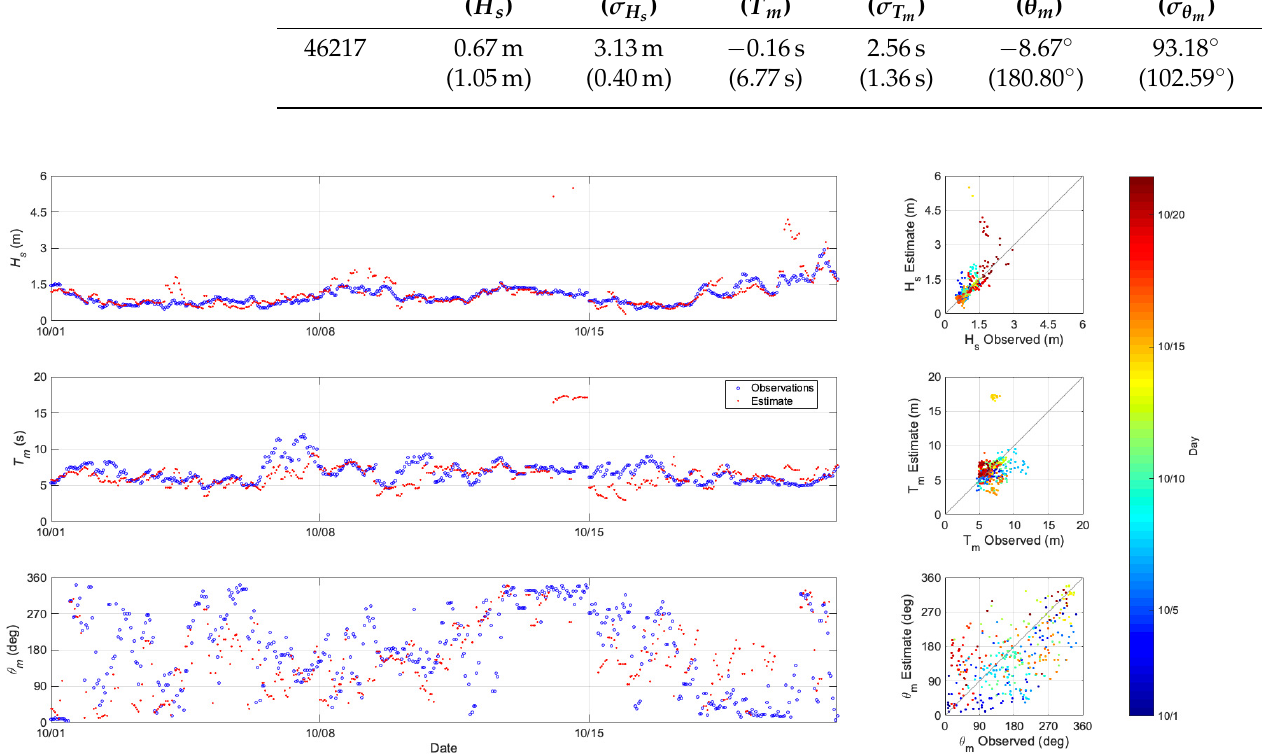
Figure 4. Comparison of estimated to observed wave parameters for buoy 46217. Top left panel is a time series of significant wave height H s ; the middle left panel is a time series of mean wave period T m ; and the bottom left panel is a time series of mean wave direction θ m . In the time series, the open circles show the observed quantities, the red dots show the HFR assimilation estimate. The right panels are the associated scatter plots colored by experiment